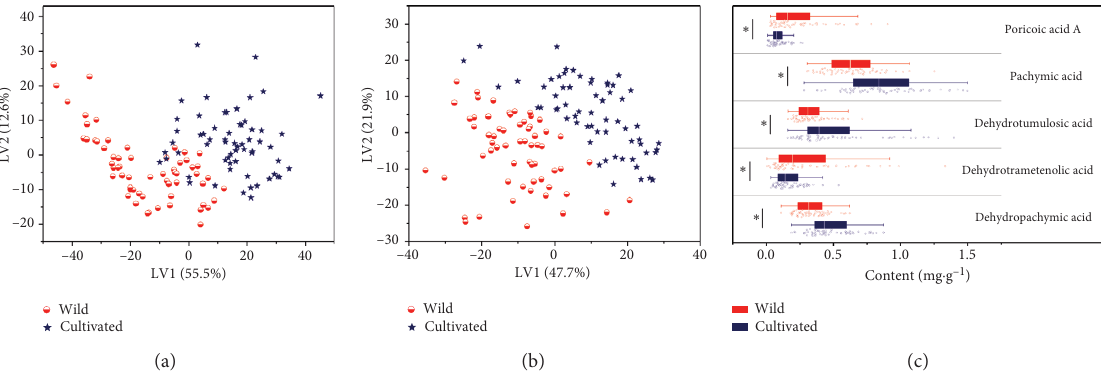
Figure 5: The PLS-DA scores scatter plot based on LC (a) and FTIR (b) data and the box-plot (c) of five triterpene acids contents (mg · g − 1 ) regarding wild and cultivated samples. ∗ P < 0 . 05.